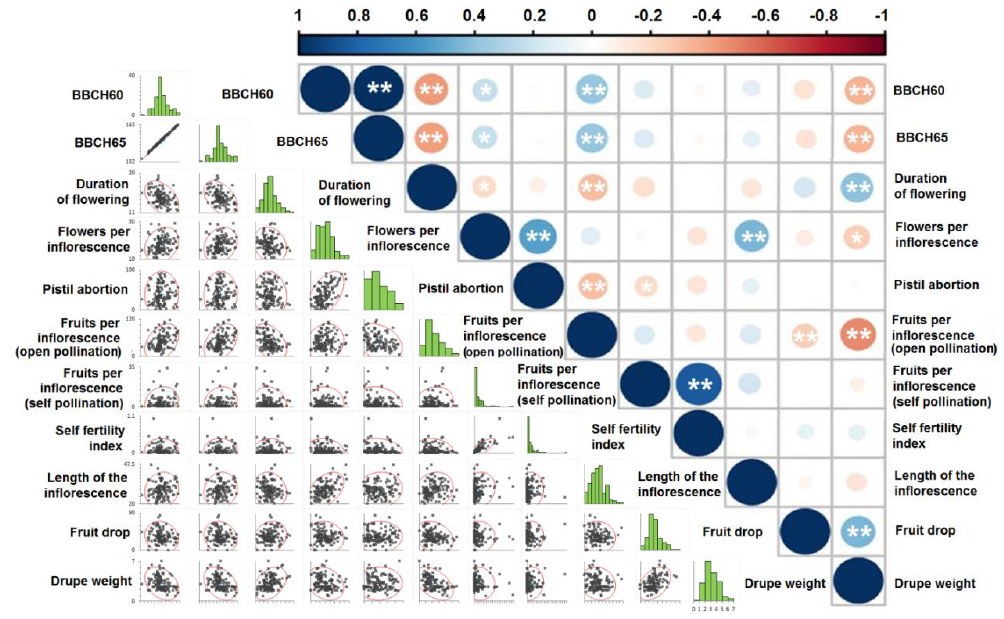
Figure 8. Correlation matrix based on Pearson’s product-moment correlation coefficient (r) between paired variables, across the eight-year trial. Asterisks denote statistical significance at 95% (*) and 99% (**) confidence levels.